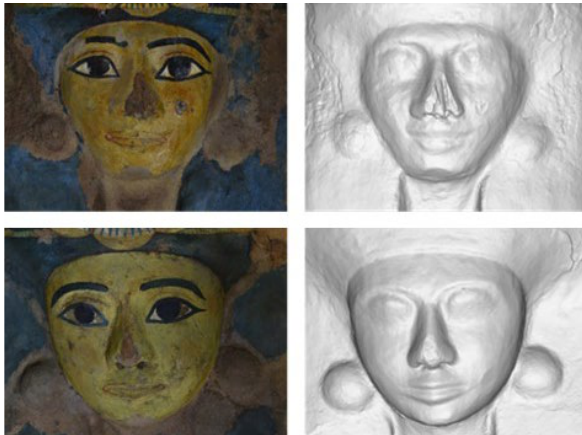
Figure 6. Comparison of digital twins and 3D models of the mummy board of Ikhy (above) and its outer coffin